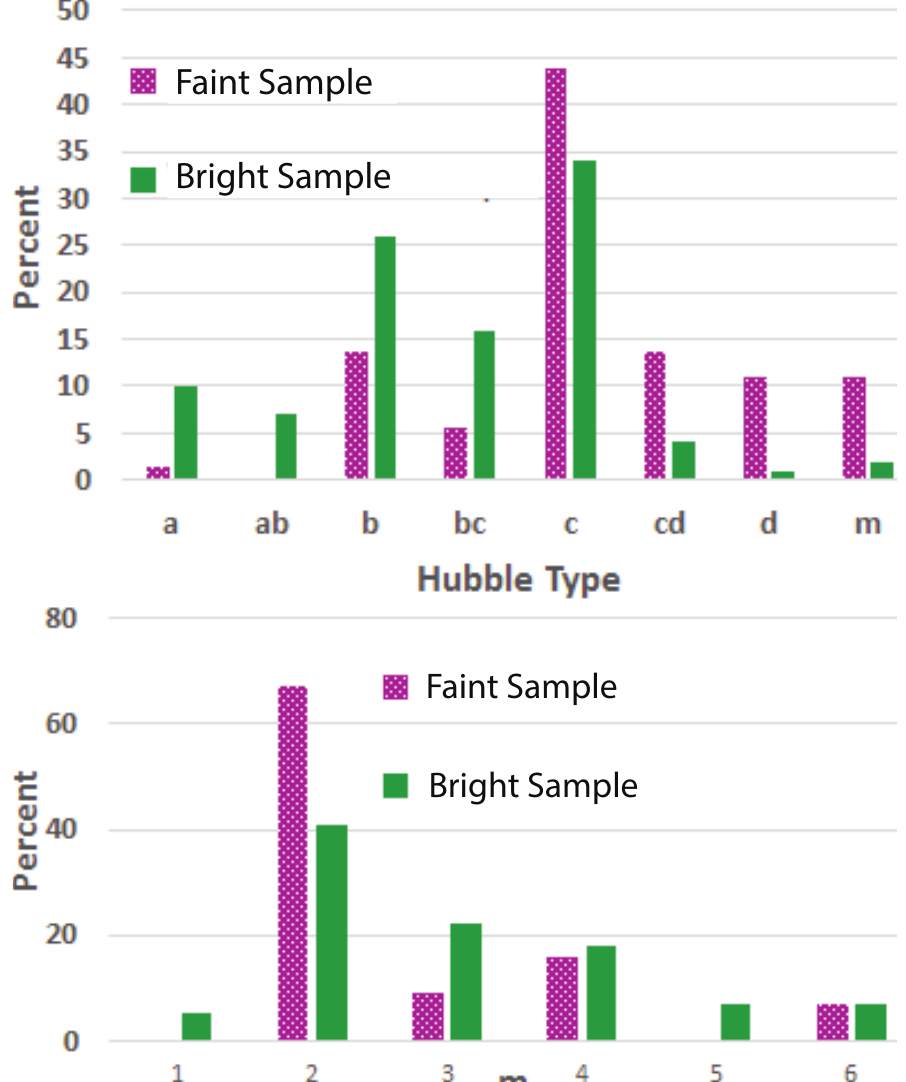
Figure 3. ( Top ) Histogram of Hubble types for all galaxies from each sample. The bright sample is comprised of spirals of medium arm winding (Sb–Sc), while the faint sample favors less bulge- dominated spirals with a high- | φ | sub-population (Sc–Sm). The average Hubble state for the bright sample is T = 3.8 ± 1.6, cf. T = 5.4 ± 1.7 for the dim sample. Hence, a morphological difference is expressed between the two selections of galaxies. ( Bottom ) The histogram of the number of arms ( m ) for the two samples are similar, with two-armed ( m = 2) galaxies being most abundant in both. Notably, the faint sample is partially comprised of flocculent galaxies which often evade pitch angle measurement or arm number attribution, as opposed to the more accurately measured grand design spirals, which are common to the earlier Davis et al. [53]